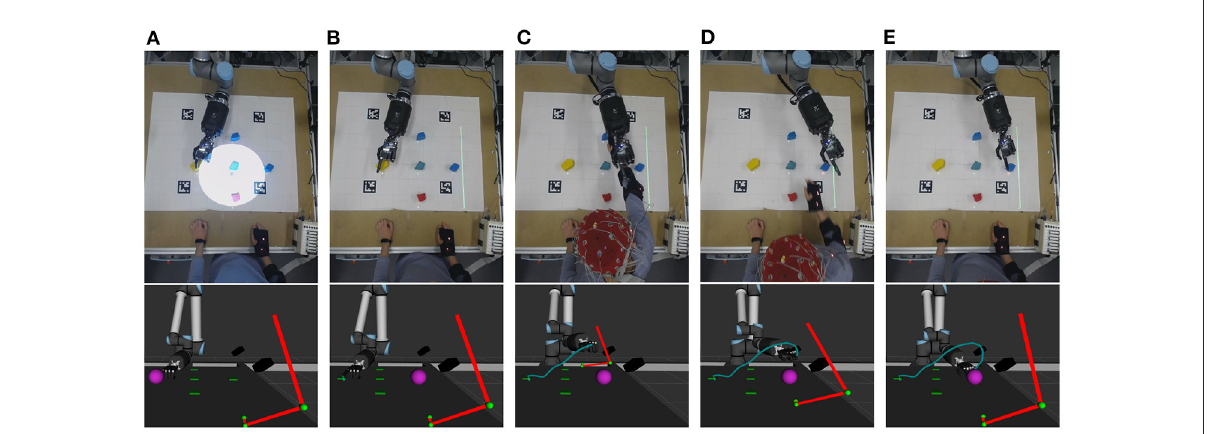
FIGURE4 Example scenario for the robot arm trajectory generation based on the operator’s movement prediction and arm tracking. The purple sphere is the goal position of the robot’s first finger tip. Red cylinders visualize the current position of the operator’s arm. The green curve represents the trajectory of the first finger tip. (A) The operator gazed at target object no. 5, and the robot touched object 4. EEG signals were collected in this state (white circle shows flicker stimulus). (B) The BCI predicted the operator will target object 5, and the robot controller adjusted its next goal